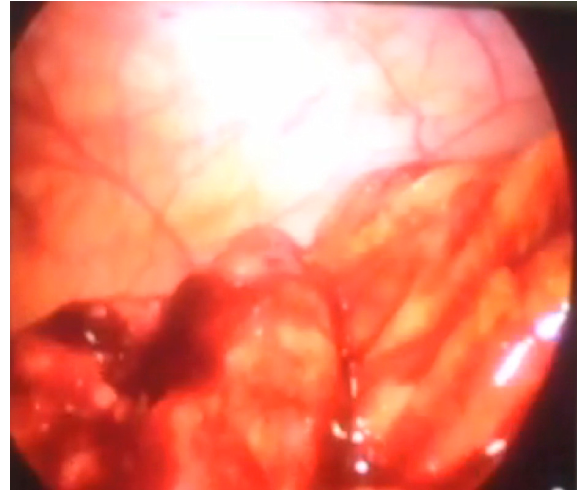
Figure 7. Edematous ileocecal valve that could be missed for